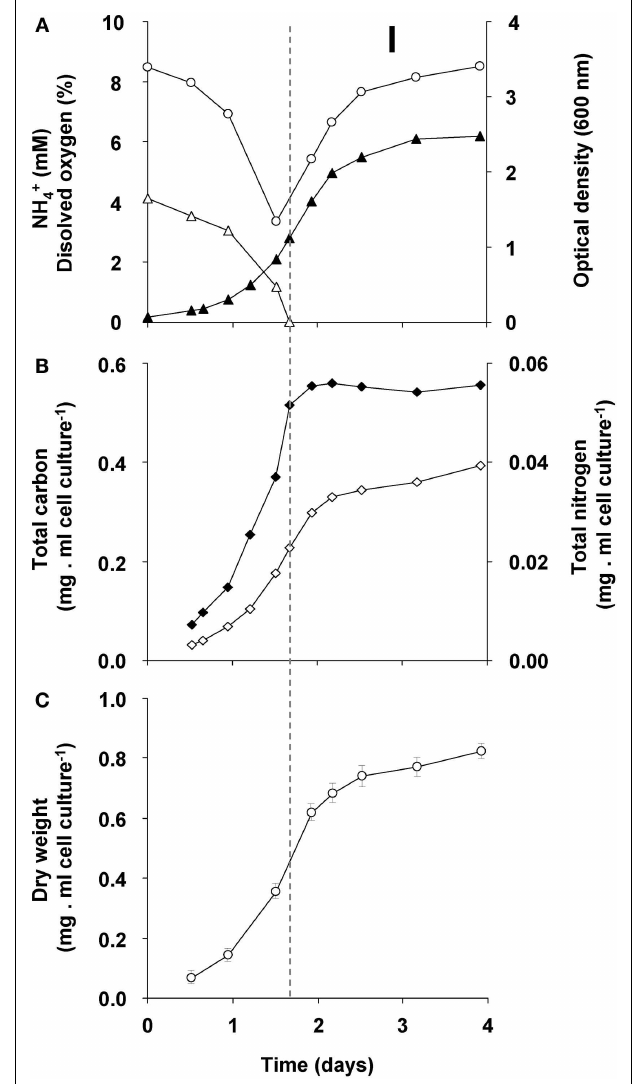
FIGURE 2 | Growth response of “ Ca. M. fumariolicum” SolV upon ammonium depletion during transition phase I (the start is indicated by the dashed line). (A) The optical density (closed triangles), ammonium (open triangles), and dissolved oxygen in culture medium (open circles). (B) Total nitrogen (closed squares) and total carbon (open squares). (C) Dry weight (open circles). Error bars represent SEM ( n =